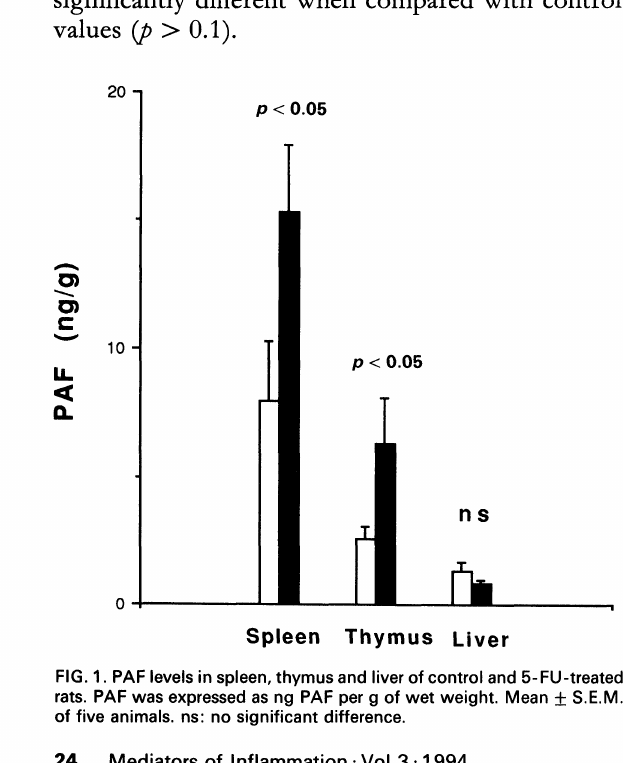
FIG. 1. PAF levels in spleen, thymus and liver of control and 5-FU-treated rats. PAF was expressed as ng PAF per g of wet weight. Mean -I- S.E.M. of five animals, ns" no significant